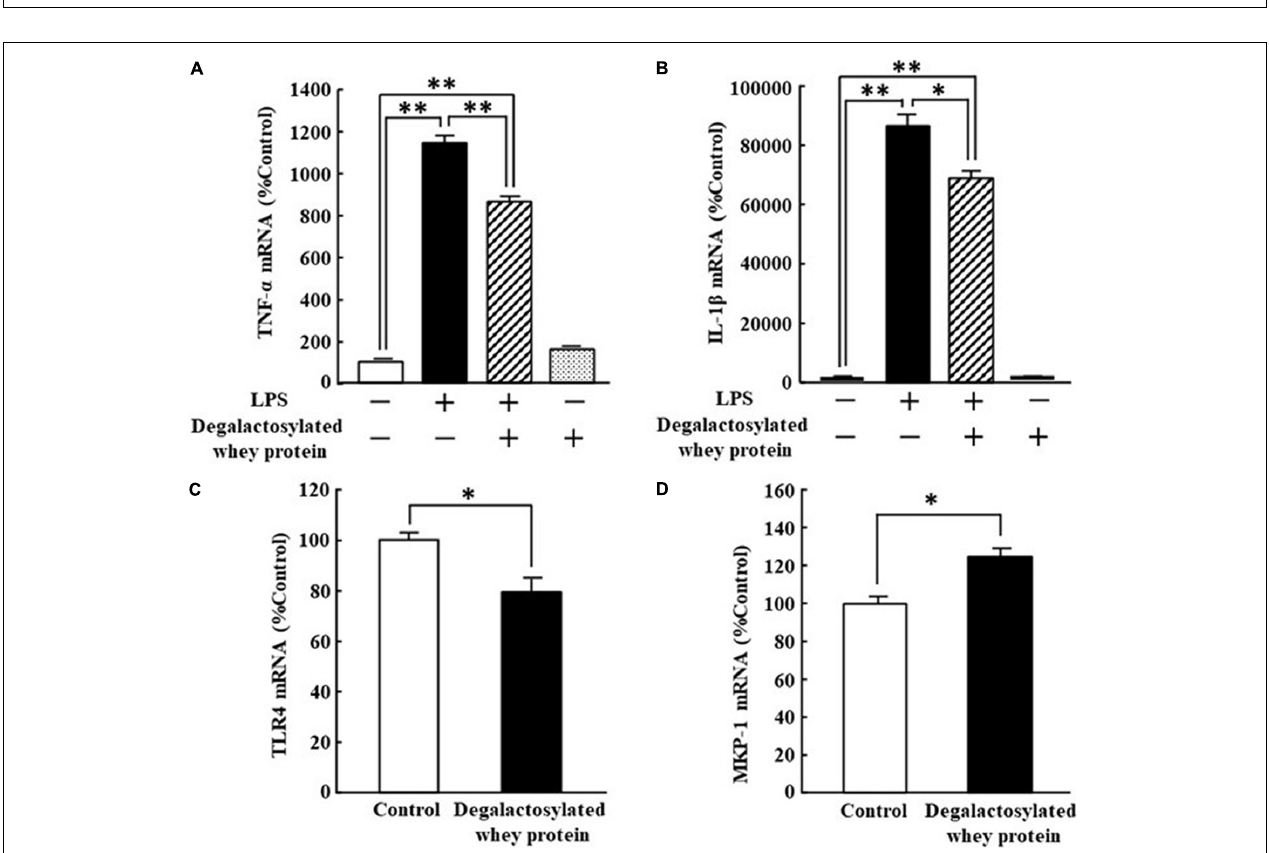
FIGURE 5 | Effects of degalactosylated whey protein on mRNA expression of TLR4 and MKP-1, and LPS-induced mRNA expression of TNF- α and IL-1 β in RAW264.7 cells. (A) Effects of 3-h preincubation with degalactosylated whey protein (100 µ g mg/ml) on mRNA expression of TNF- α induced by LPS (5 ng/ml) after incubation for another 3 h. (B) Effects of 3-h preincubation with degalactosylated whey protein (100 µ g mg/ml) on mRNA expression of IL-1 β induced by LPS (5 ng/ml) after incubation for another 3 h. (C) Effects of 3-h incubation with degalactosylated whey protein (100 µ g mg/ml) on mRNA expression of TRL-4. (D) Effects of 3-h incubation with degalactosylated whey protein (100 µ g mg/ml) on mRNA expression of MKP-1. Results are expressed as mean ± SE for 8–12. ∗ p < 0.05, ∗∗ p < 0.01.